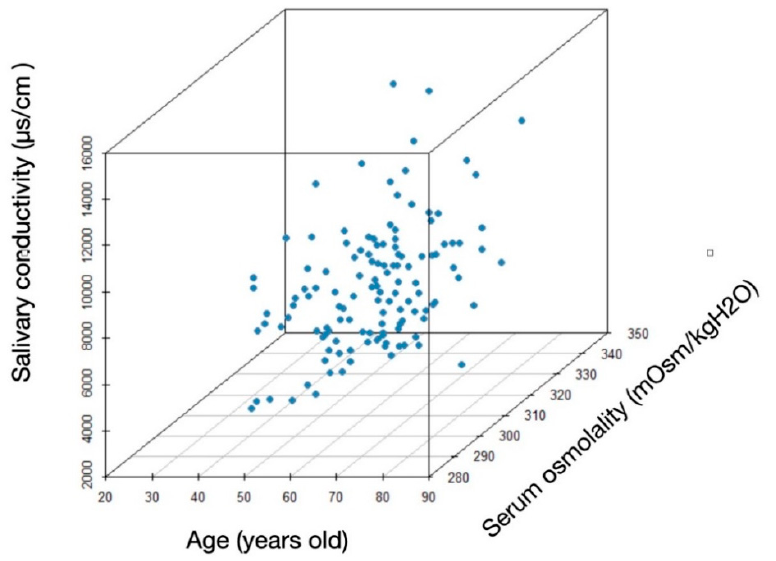
Figure 4. The receiver operating characteristic curve analysis. The receiver operating characteristic curves were built from four prediction models for the diagnosis of cardiomegaly. The area under the ROC curve (AUROC) was equal to 0.626 (95% CI: 0.521–0.730, p = 0.02) when salivary conductivity was the predicting factor. The combination of salivary conductivity, serum sodium, and history of diabetes mellitus showed a significant increase in AUROC (0.782, 95% CI: 0.696–0.868). Abbreviations: AUC, area under the curve; DM, diabetes mellitus; Na, serum sodium; Osm, serum osmolality.